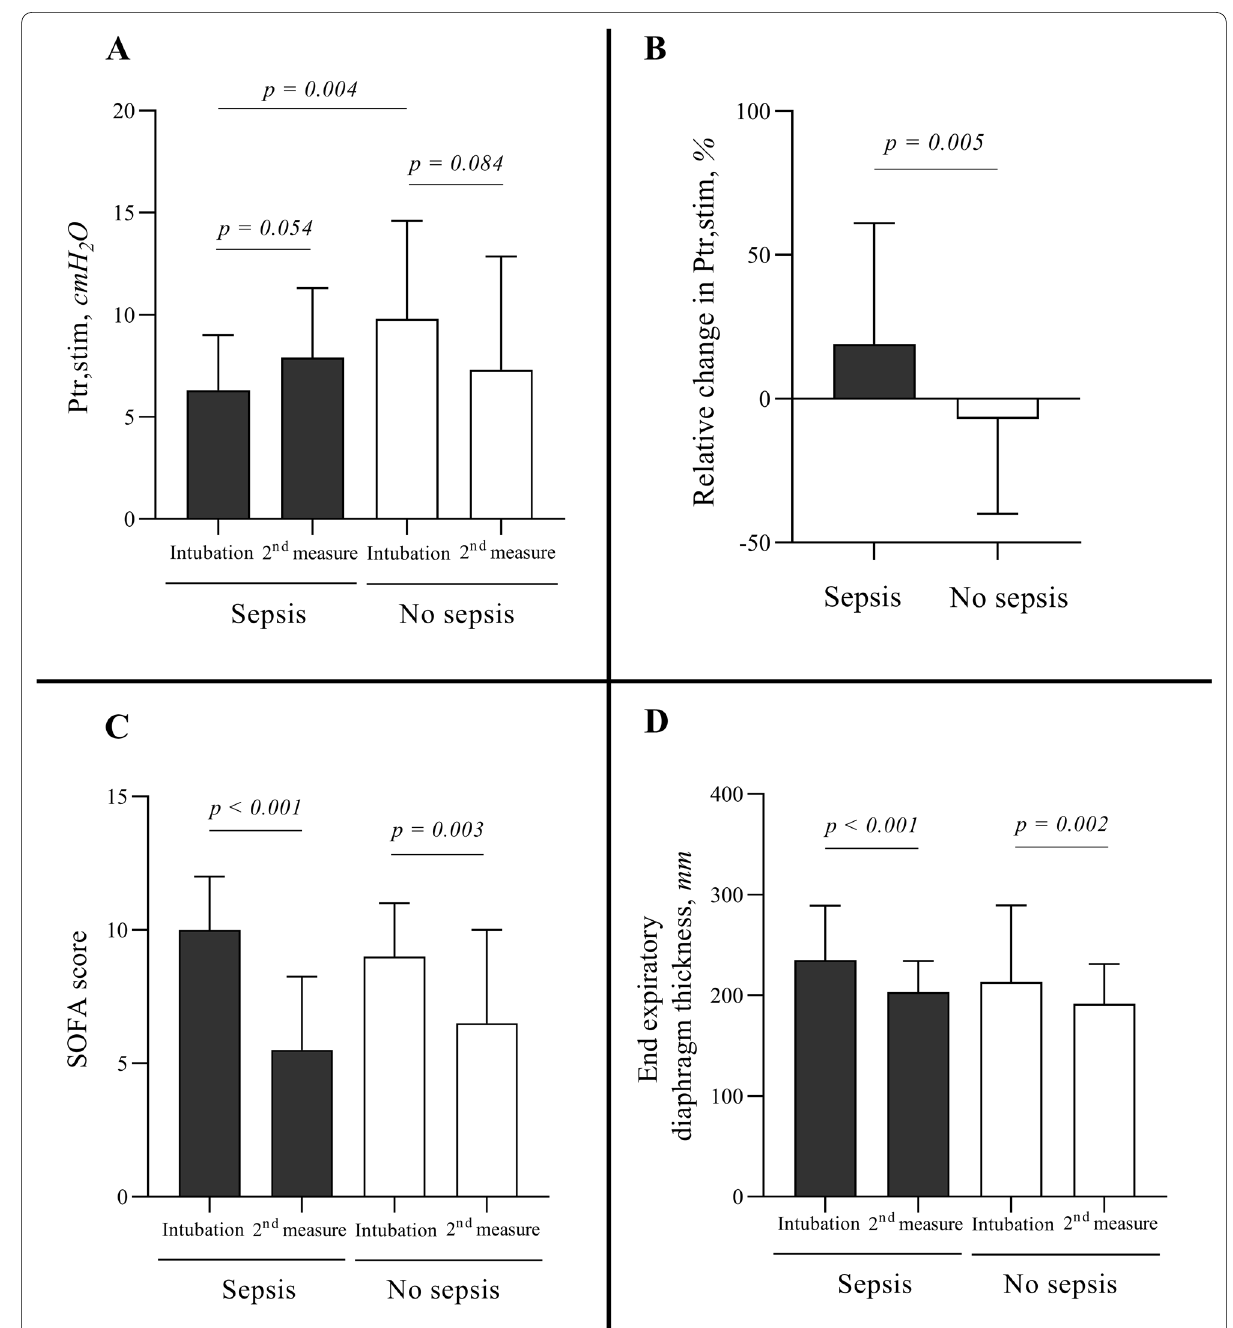
Fig. 1 A Endotracheal tube pressure induced by bilateral phrenic nerve stimulation during airway occlusion (Ptr,stim) at inclusion (< 24 h of intubation) and at the second measure (pressure support mode) in septic and non-septic patients. p identified by Wilcoxon matched-pairs test. B Relative changes (%) in endotracheal tube pressure induced by bilateral phrenic nerve stimulation during airway occlusion (Ptr,stim) between the two measurements (inclusion and pressure support mode) in septic and non-septic patients. p identified by Mann–Whitney test. C SOFA score at inclusion (< 24 h of intubation) and at the second measure (pressure support mode) in septic and non-septic patients. p identified by paired t test. D End-expiratory diaphragm thickness measured by ultrasound at inclusion (< 24 h of intubation) and at the second measure (pressure support mode) in septic and non-septic patients. p identified by Wilcoxon matched-pairs test. Box plot represent median with interquartile